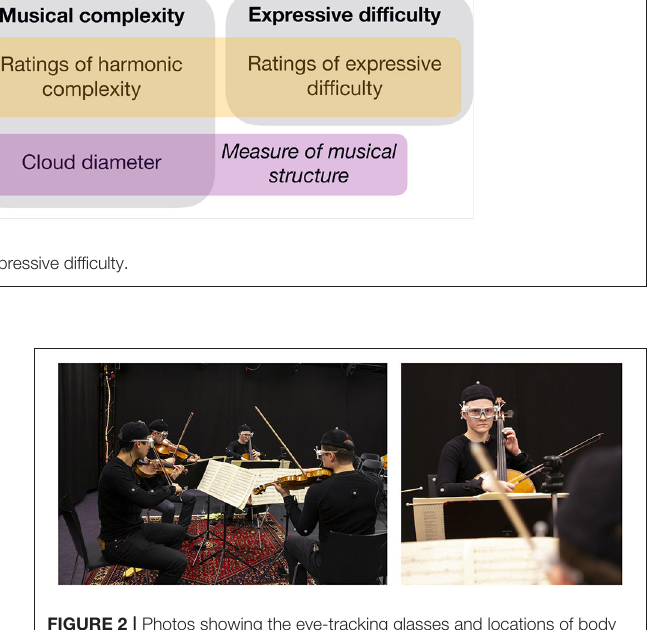
FIGURE 2 | Photos showing the eye-tracking glasses and locations of body markers on the musicians. Photo credit: Annica